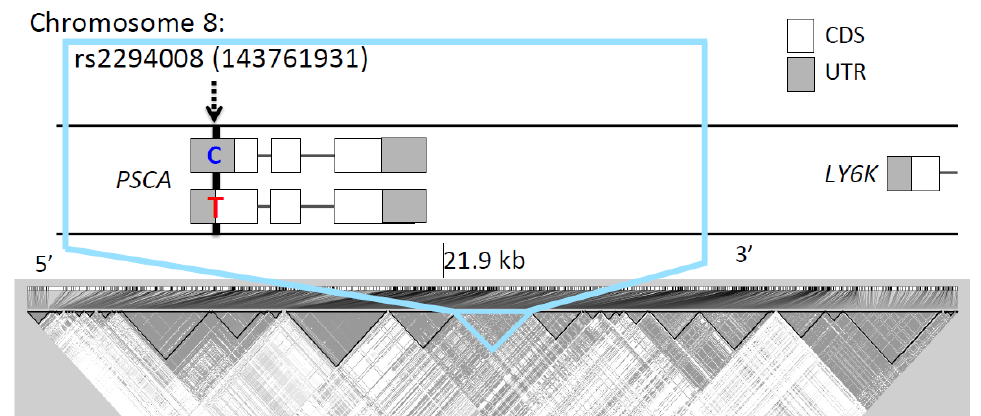
Figure 3. Genomic context (upper) and linkage disequilibrium (lower) of rs2294008. The gray and white squares represent coding sequence (CDS) and untranslated region (UTR) of a gene, respectively. rs2294008 (T / C) is located in a PSCA initiation codon (chr8: 143,761,931). Sequences with the C allele are truncated by nine amino acids compared with sequences with the T allele